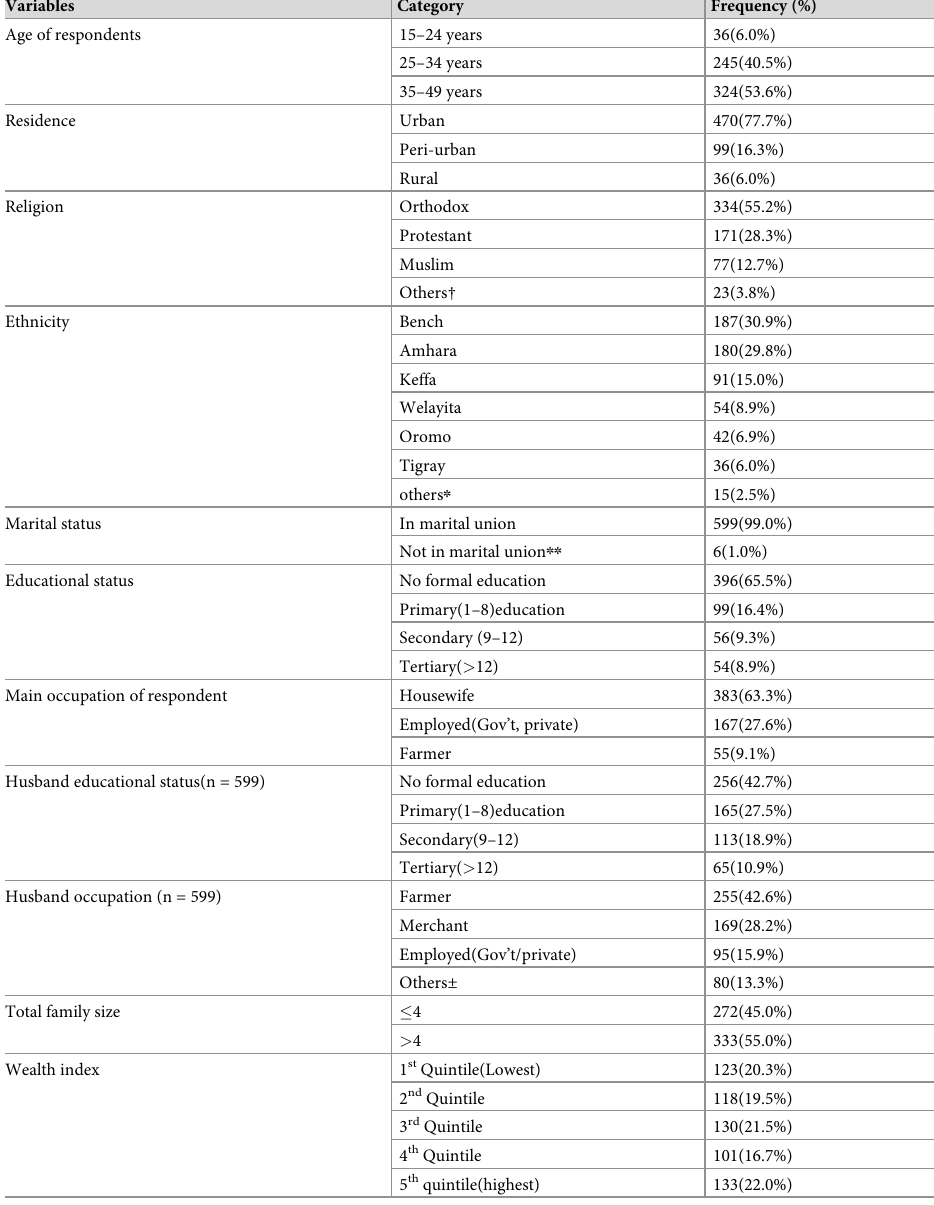
Table 1. Socio-demographic characteristics of reproductive age women in Mizan-Aman town, Bench-Sheko Zone, Southwest Ethiopia, 2020(n = 605).